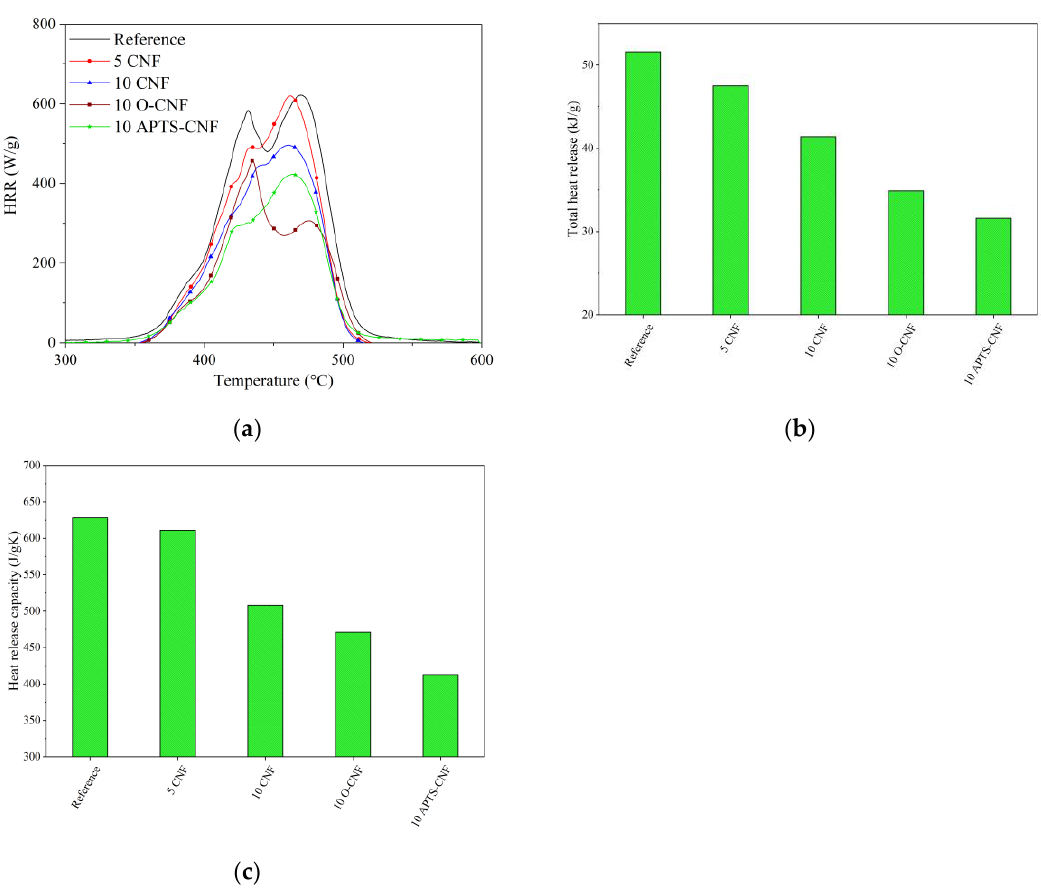
Figure 15. Results of microscale combustion calorimetry measurements: ( a ) heat release rate, ( b ) total heat release, ( c ) heat release capacity.